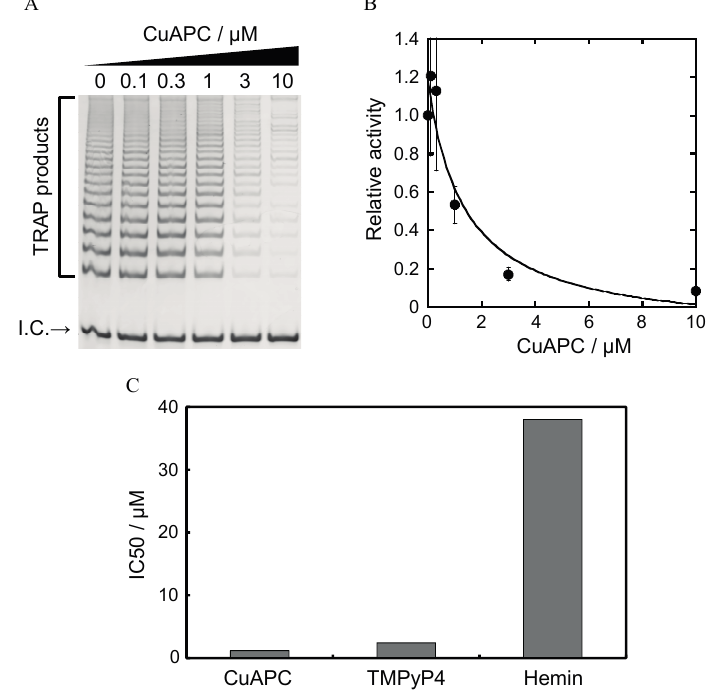
Figure 6. ( A ) Electrophoresis results from the two-step TRAP assay with 0–10 µM CuAPC. I.C. indicates the internal control for PCR amplification; ( B ) Relative activity of telomerase with 0–10 µM CuAPC. The relative activity value of 1 corresponds to the positive control ( i.e ., without CuAPC); ( C ) Comparison of the IC50 value of each ligand for telomerase